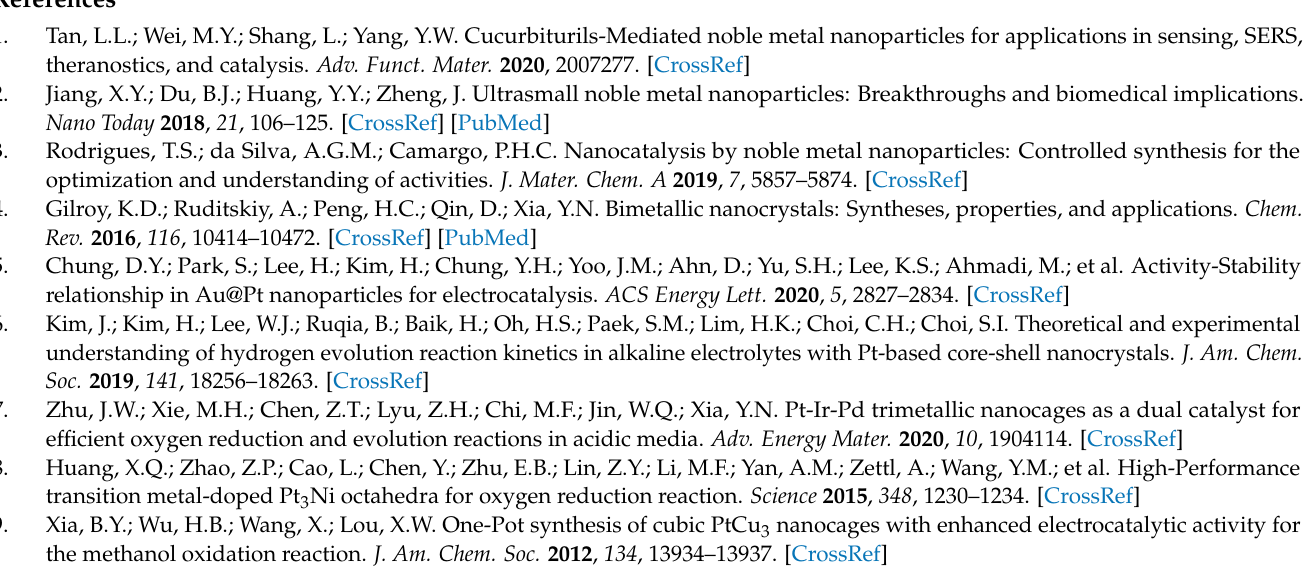
Figure S2: HAADF-STEM-EDS mapping images and EDS line scanning profiles of Pd@Fe